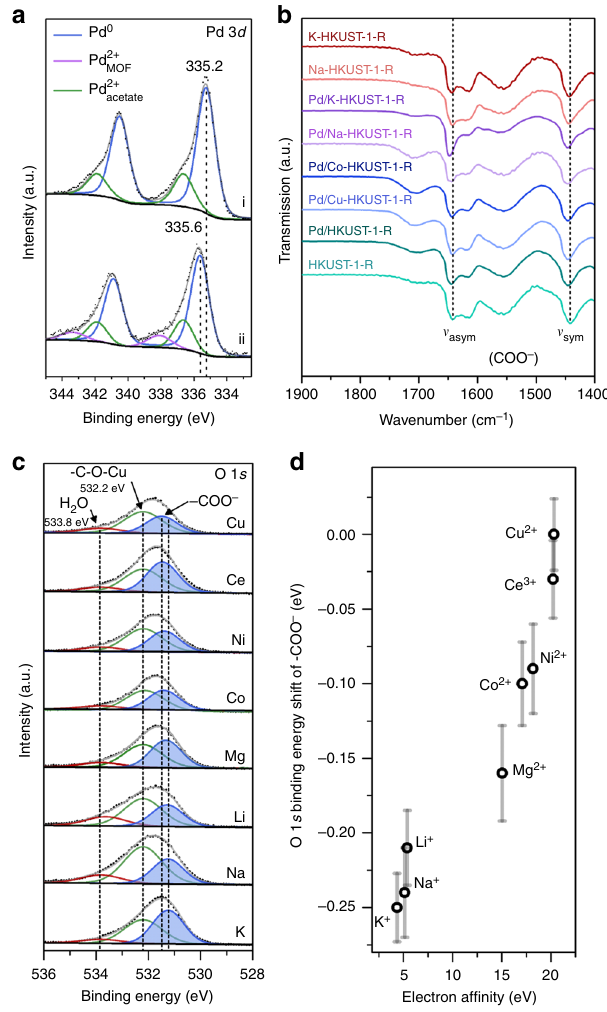
Fig. 4 Spectroscopic characterisation of Pd/HKUST-1-R and Pd/ M -HKUST- 1-R. a XPS Pd 3 d spectra of (i) bare Pd NPs (Supplementary Fig. 8) and (ii) Pd/HKUST-1-R. b FTIR spectra of HKUST-1-R and its various derived products. c XPS O 1 s spectra of the various cation-exchanged Pd/ M - HKUST-1-R. d Shift in O 1 s binding energy with respect to the EA of the counterions. The error bars represent the standard deviations of the data points ( n =